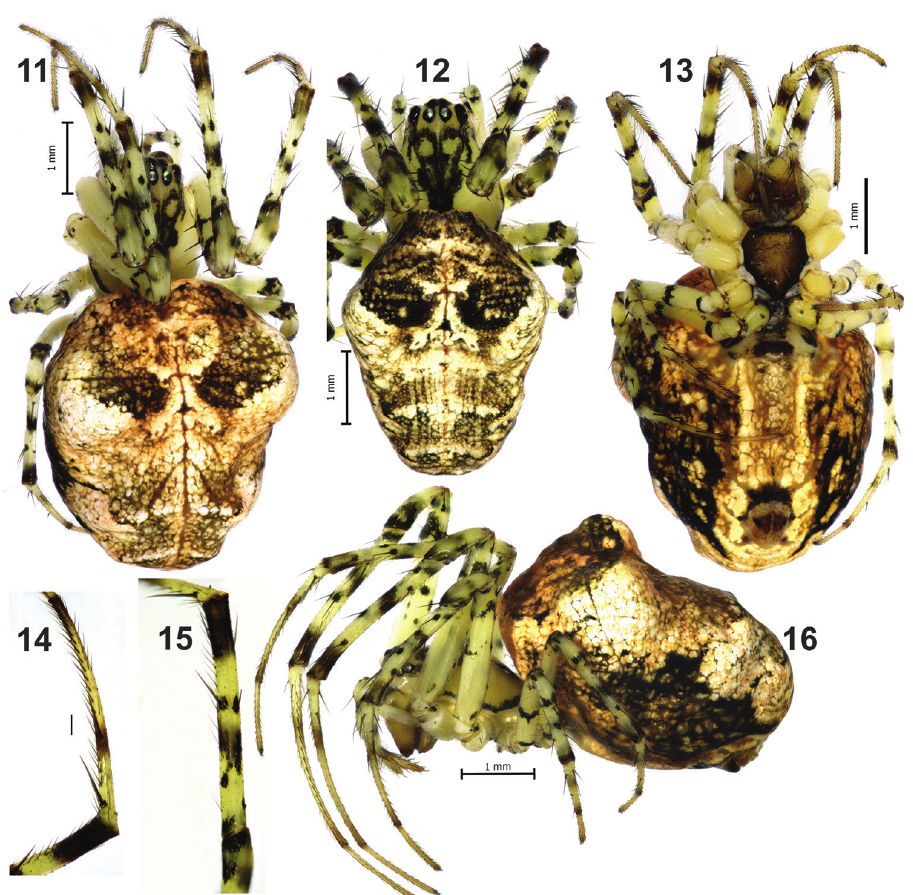
showing differences in size and colour pattern 13, 16 habitus, ventral and lateral 14 metatarsus I pro- lateral, showing row of stiff setae 15 tibia I, prolateral. Scale bars 1 mm ( 11, 12, 13, 16 ); 0.2 mm ( 14 )